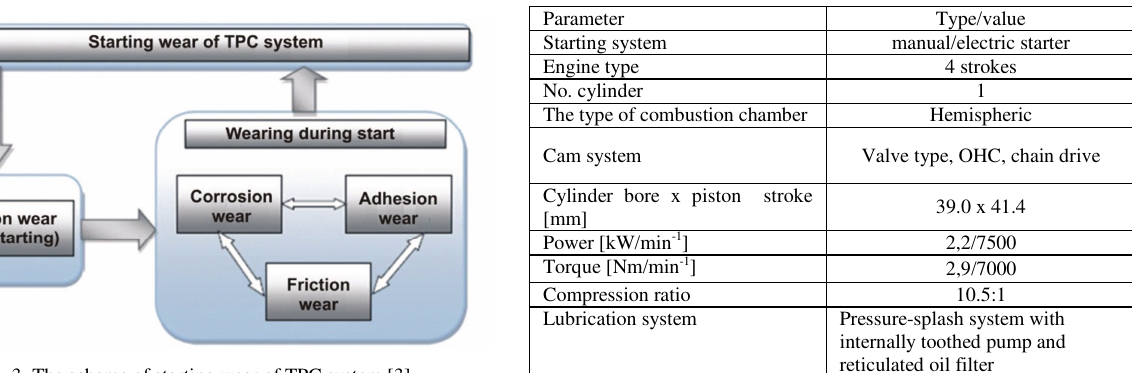
Table1. Technical data of engine 139QMA